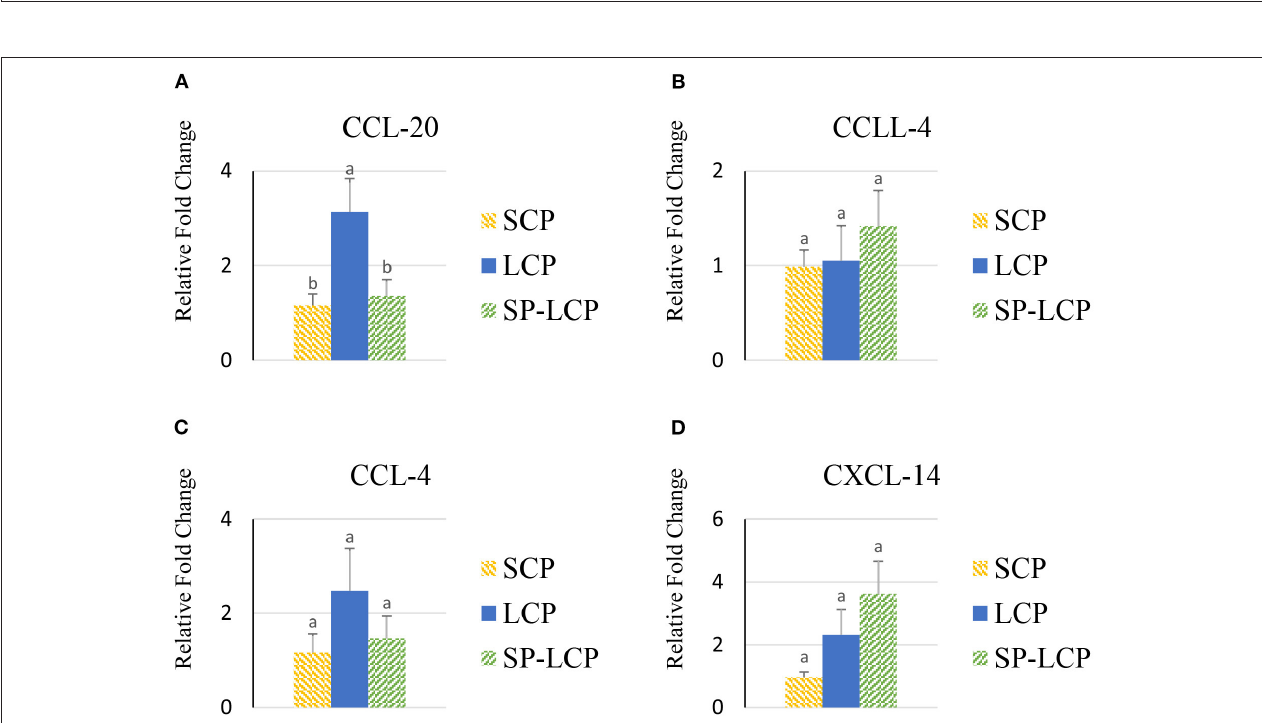
FIGURE 3 | Effects of Spirulina on circulating chemokine expression profile. Relative mRNA abundance of circulating chemokine (C-C motif) ligand 20 (CCL-20) (A) , chemokine-like ligand 4 (CCLL-4) (B) , chemokine (C-C motif) ligand 4 (CCL-4) (C) , and chemokine (C-X-C motif) ligand 14 (CXCL-14) (D) in broilers on day (d) 37 were determined by real-time qPCR. Treatments include standard corn/soy (SCP) diet as control and low crude protein without (LCP) or with Spirulina (SP-LCP). Data are presented as mean ± SEM ( n = 8/group). Means with different letters are significantly different ( P < 0.05).